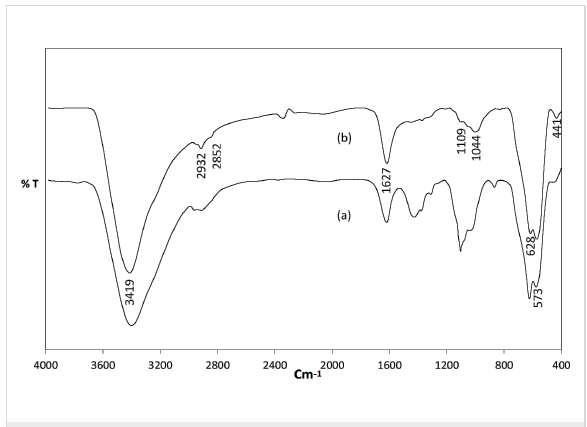
Figure 1: FTIR spectrum of (a) naked SPION (b) APTES-functional- ized SPION. The binding of APTES onto the SPION is revealed by the 1109 and 1044 cm − 1 peaks assigned to the Si–O–Si bond.